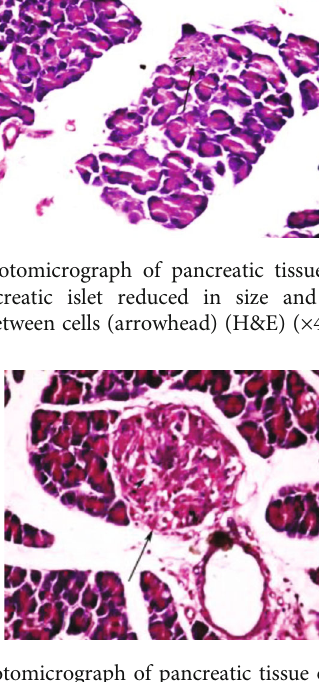
Figure 4: Photomicrograph of pancreatic tissue of P. granatum (100mg/kg BW)-treated animal showing pancreatic islet (arrow) with vacuolation in between cells (arrowhead) and atrophied pancreatic acini (A) (H&E) ( ×